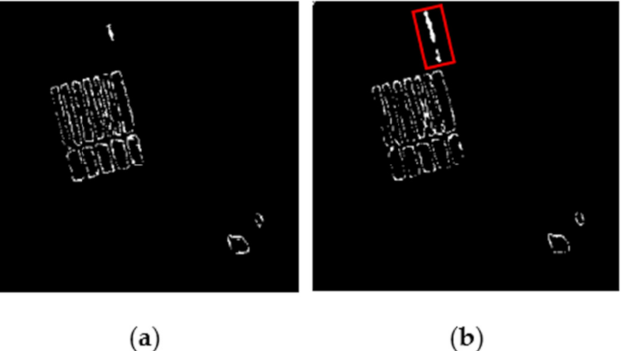
Figure 20. Wrongly classified pixels in the final change map. ( a ) Error pixels for Gabor-PCANet. ( b ) Error for our proposed